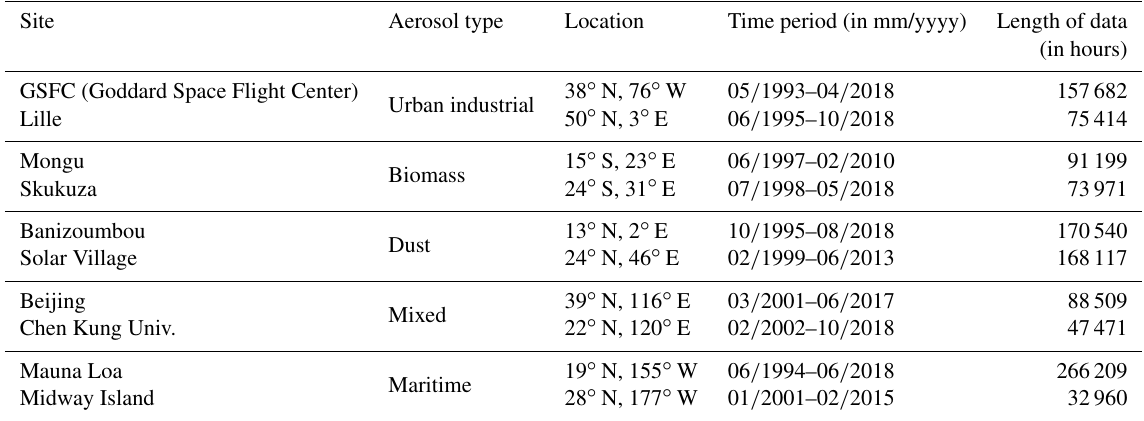
Figure 3. Relationship between the Ångström exponent ( q ) and AOD at a wavelength of 0.87µm at 10 typical sites (a) . Distribution of absolute value of relative error (b, c) of AOD data converted to a wavelength of 0.44 caused by erroneous values of q obtained in the calibration, using scheme 1 and scheme 2, respectively. Table 1. Details of AERONET sites used to obtain Ångström exponents ( q ) and AOD